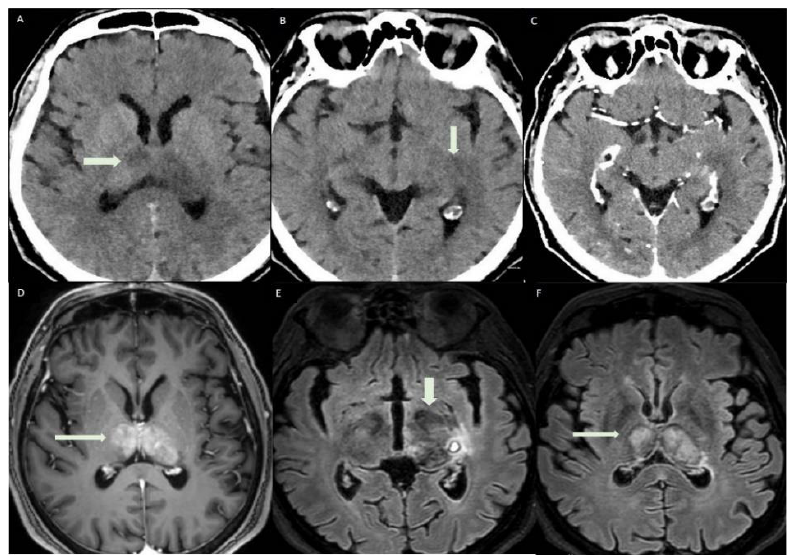
Figure 5. ( A – C ) Axial CT images show regular densitometric evolution of ischemic areas, with less hypodensity and reduction in hemorrhagic focus in the left parahippocampal region. ( D ) Axial TSE T1-weighted post contrast sequence documents reperfusion phenomena in both thalami (arrow); In ( E , F ), axial FLAIR-weighted sequences show a reduction in the diameter of hemorrhagic focus, compared to the first MRI exam, and less intense signal in the ischemic foci.